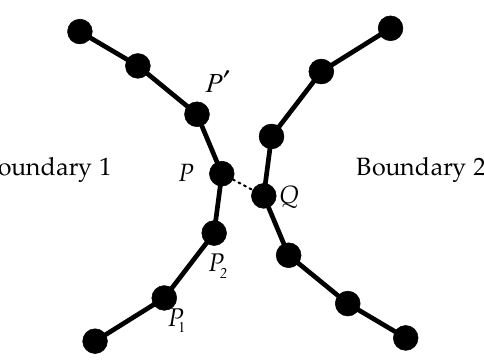
Figure 6. Two holes “adhere” to each other.